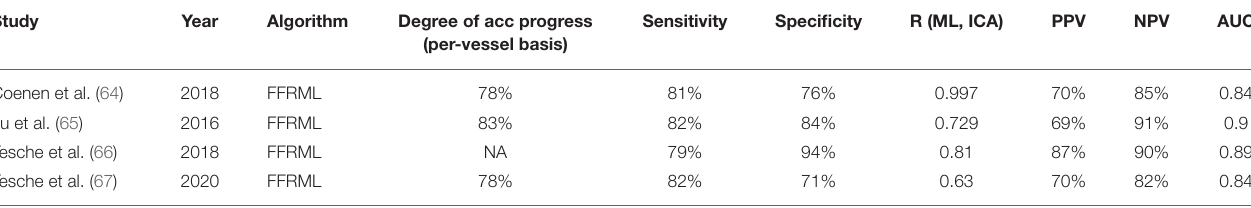
TABLE 6 | Application of artificial intelligence in CT-derived fractional flow reserve. Study Year Algorithm Degree of acc progress (per-vessel